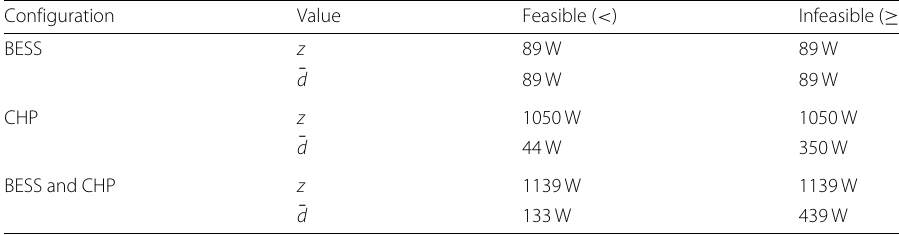
Table 4 Thresholds used in load profile